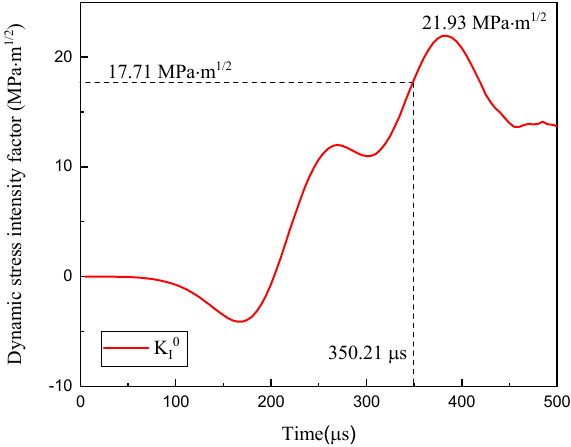
Figure 14. The curve of dynamic stress intensity factor (SIF) versus time and determination method of propagation dynamic stress intensity factor (DSIF).